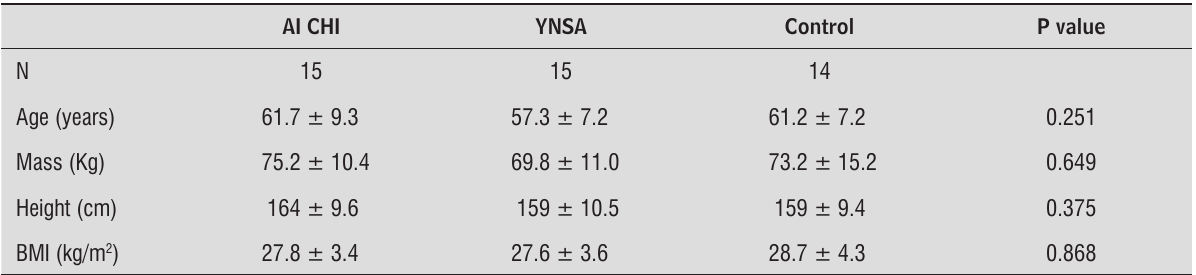
Table 1 - Mean and standard deviation of the variables age, mass, height and BMI of the groups AI CHI, YNSA and CON- TROL; p-value of the analysis of variance – one way factor